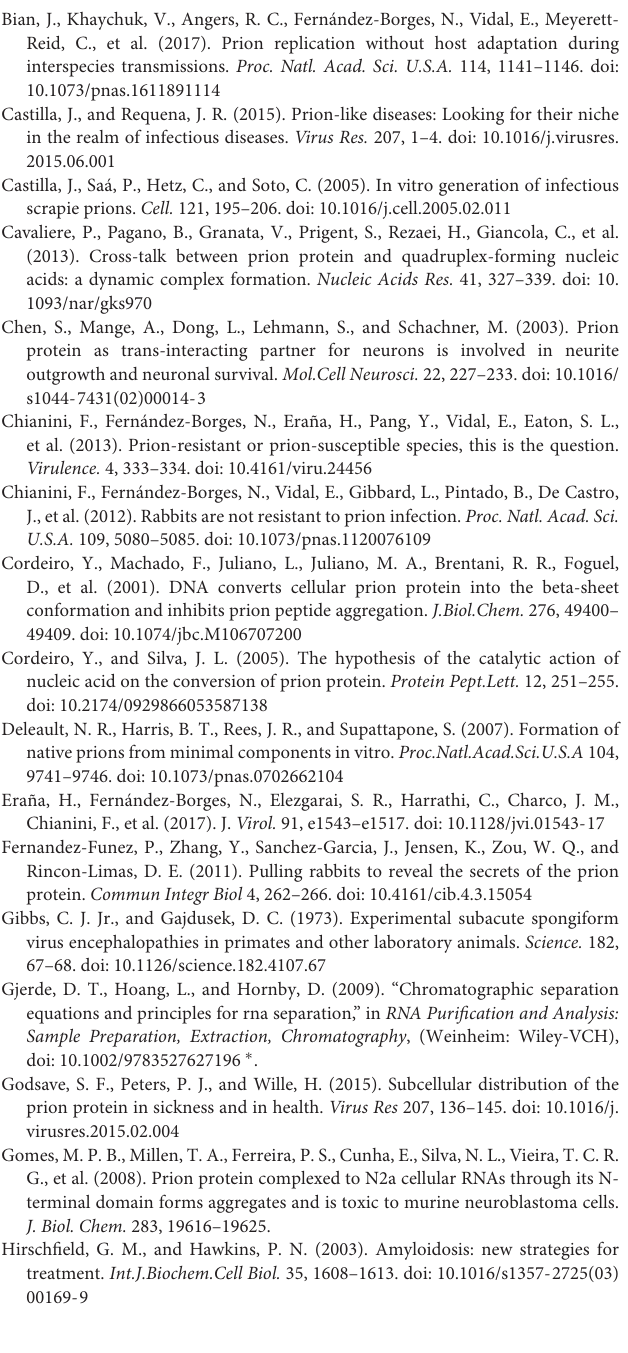
100 mM NaCl at pH 5.5. All experiments were performed at 25 ◦ C. Representative data from three experiments. Supplementary Figure 3 | PrP 90 − 231 intrinsic fluorescence reduction effect is caused by DNA oligonucleotides. Percentage curves of the PrP total intrinsic fluorescence intensity for titrations at pH 5.5 or 7.4. (A) MuPrP 90 − 231 and (B) RaPrP 90 − 231 5 µ M PrP 90 − 231 . The experiments were performed in 50 mM